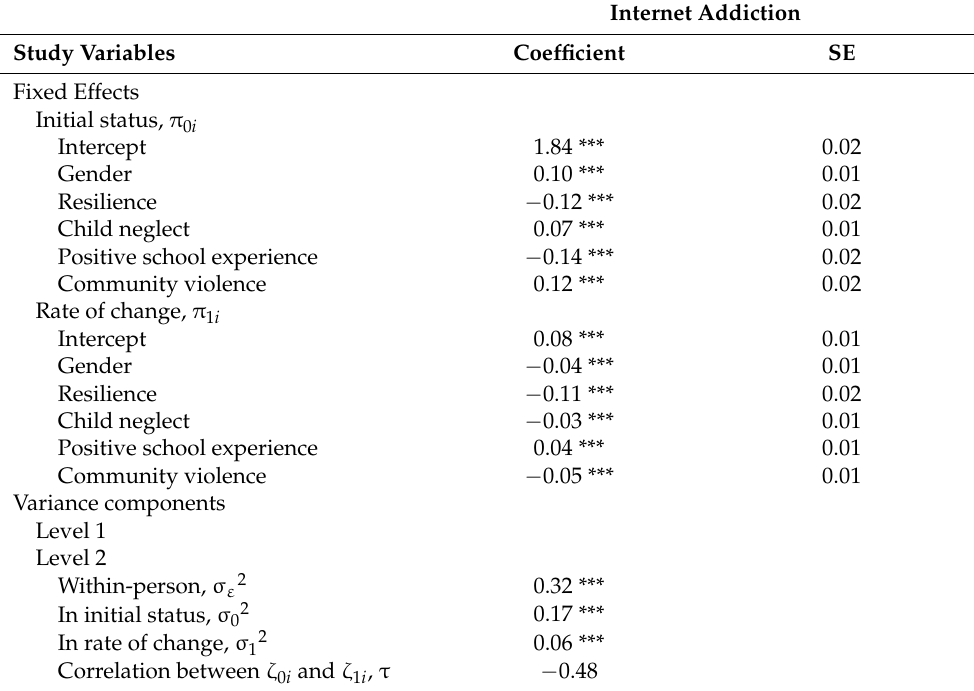
Table 2. Multilevel models for change across time for internet